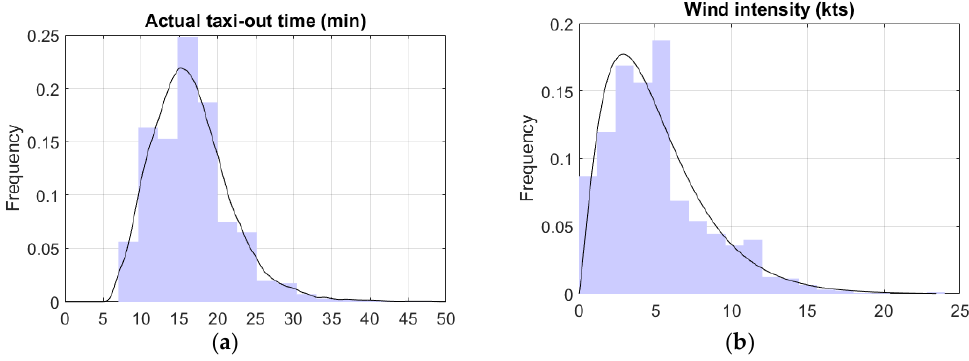
Figure 8. Histogram and distribution fitting for ( a ) actual taxi-out time (min) and ( b ) wind intensity (kts).